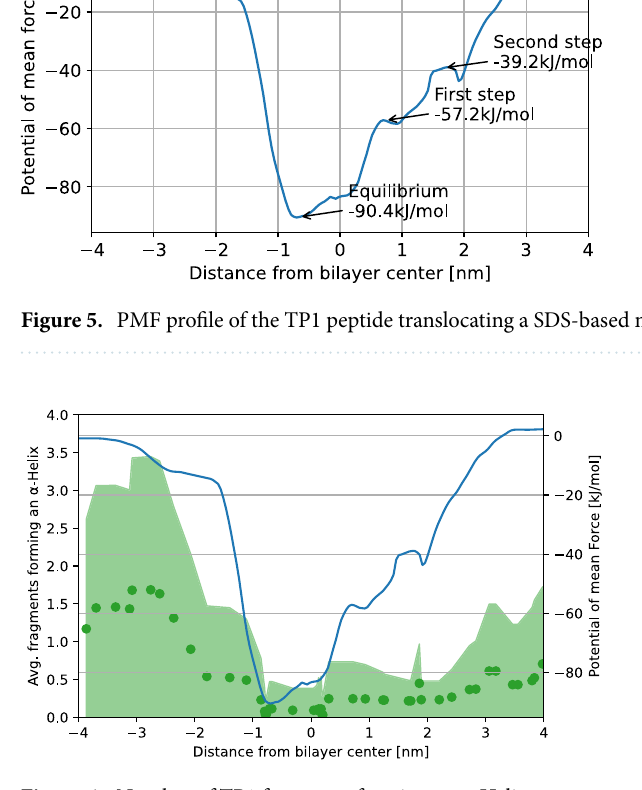
Figure 6. Number of TP1 fragments forming an α -Helix structure according to the distance from the bilayer center, time-average values shown as green dots and standard deviation shown as a green shaded area. PMF profile of the same peptide translocating the SDS-based membrane mimetic is shown in a blue line.